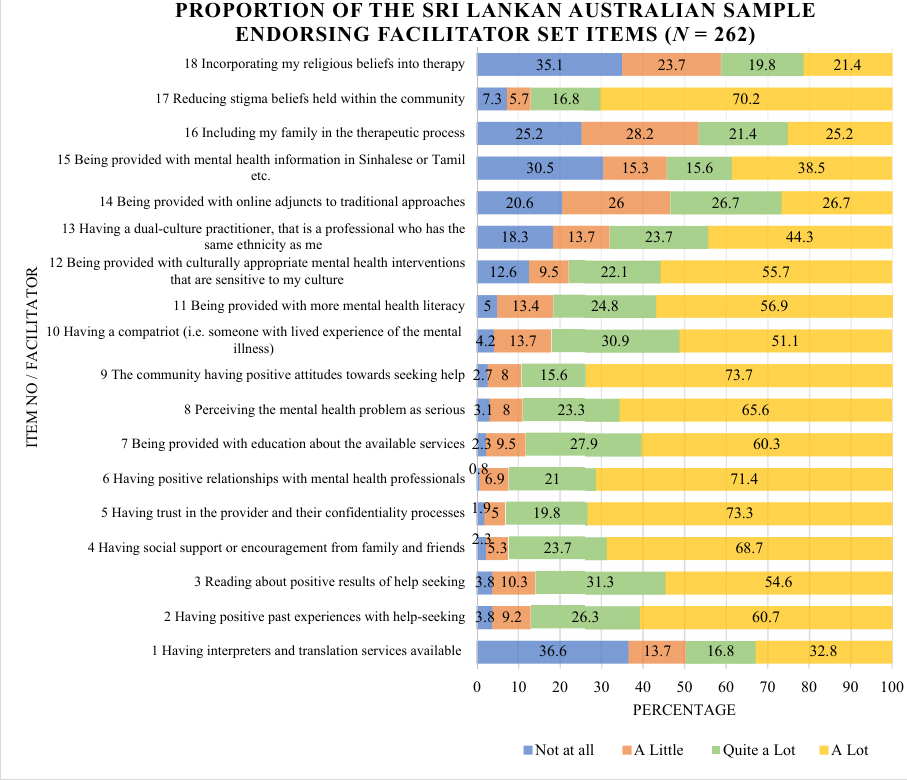
Figure 1. Proportion of the sample endorsing Facilitator Set items ( N = 262).